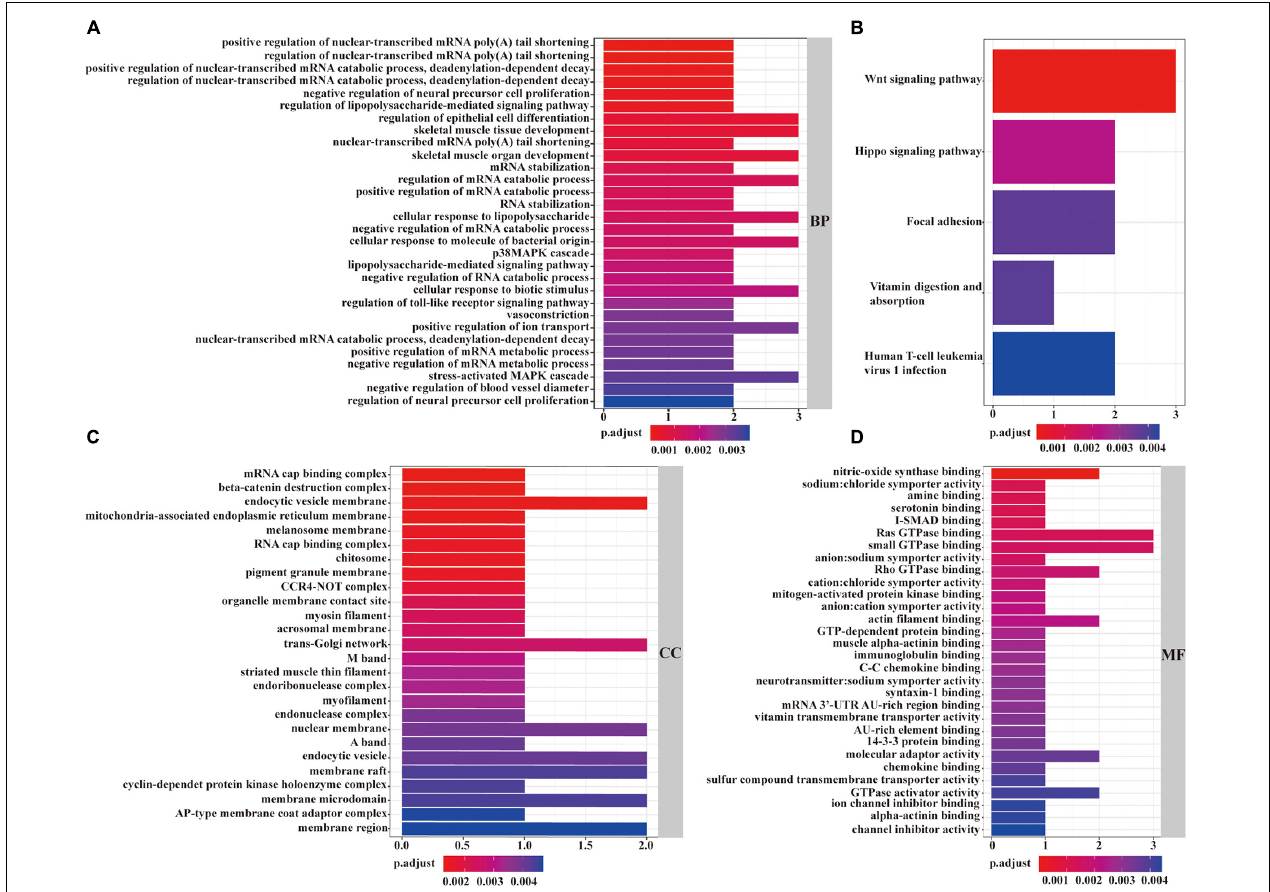
FIGURE 6 | GO and KEGG functional enrichment analyses of mRNAs in the ceRNA network. The enrichment of biological processes is shown in (A) . The enrichment of cellular components was described in (C) . The enrichment of molecular functions is displayed in (D) . The enrichment analysis of KEGG pathways is shown in (B) . A p < 0.05 was considered to indicate a statistically significant